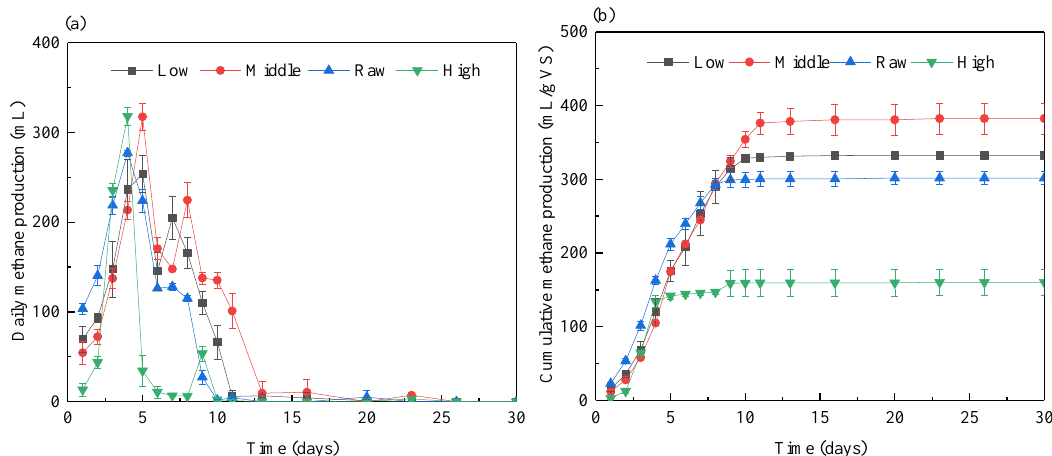
Figure 5. ( a ) Daily methane production and ( b ) cumulative methane production with different blackwater initial TAN concentrations (Low, Middle, Raw, and High represent that the blackwater initial TAN concentrations are 1541, 2388, 4488, and 6318 mg/L, respectively).